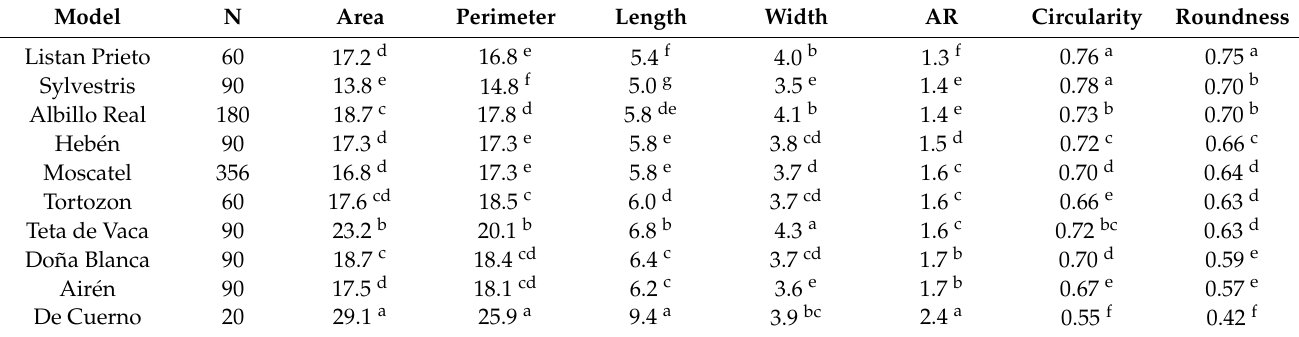
Table 2. Mean values for morphological characters in the groups corresponding to the differentmodels. Groups are denominated by the corresponding model and appear ordered by increasing values of aspect ratio (AR). The mean values marked with the same letter in each column do not differ significantly at p < 0.05 (Scheffe’s test). N is the number of seeds analysed.